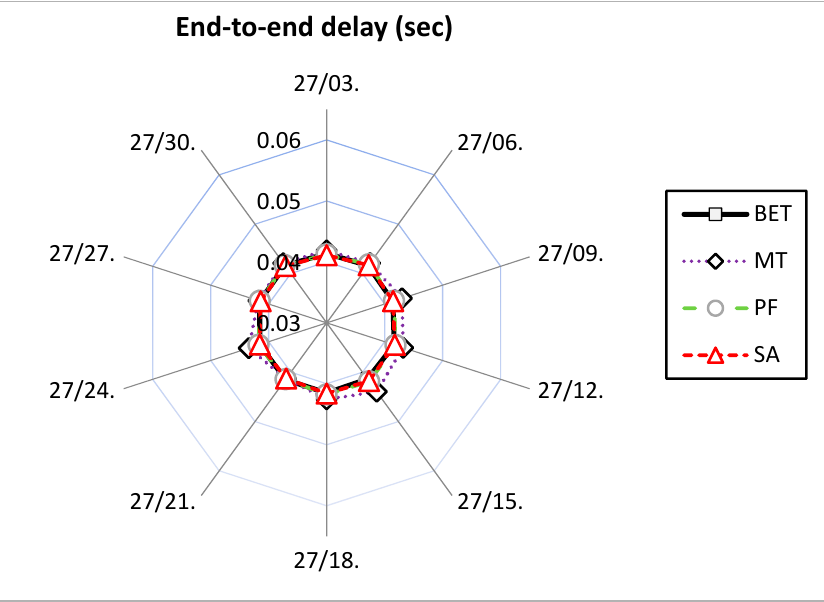
Figure 8. Average packet end-to-end delay for voice far users in mixed traffic.